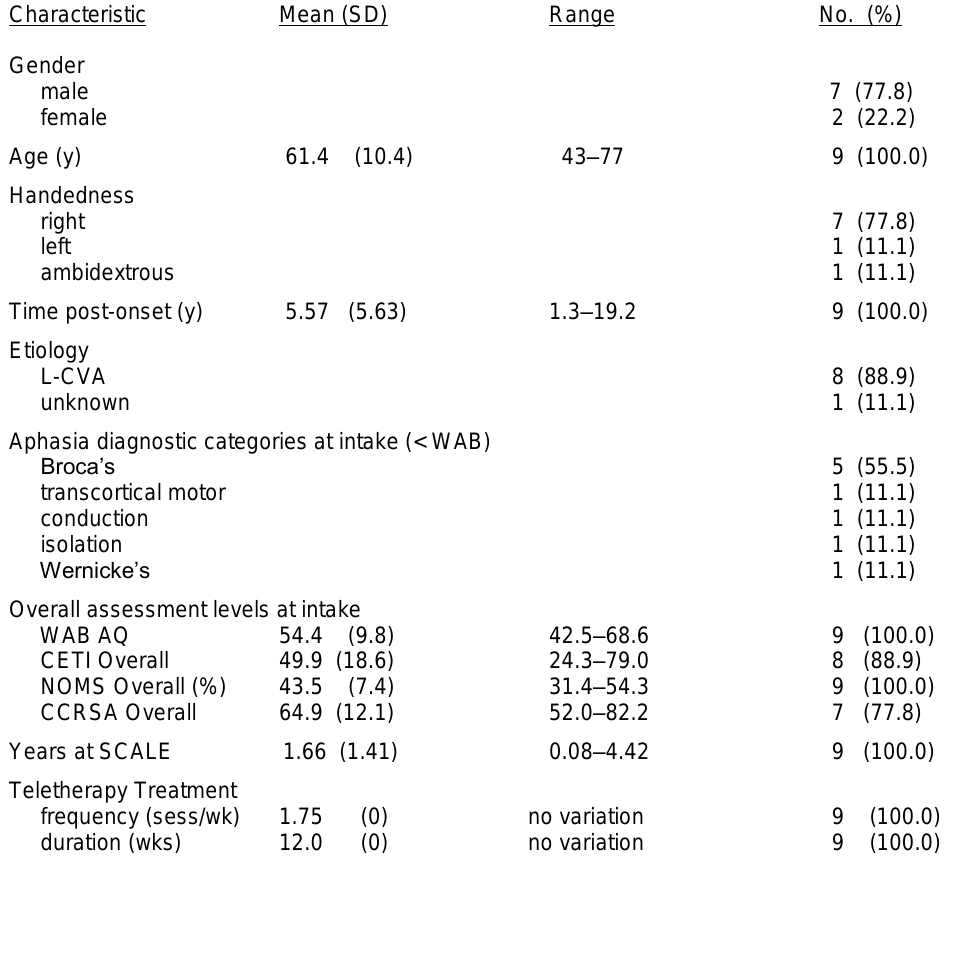
Table 2. Demographic/Clinical Data Summary for SCALE Participants with Chronic